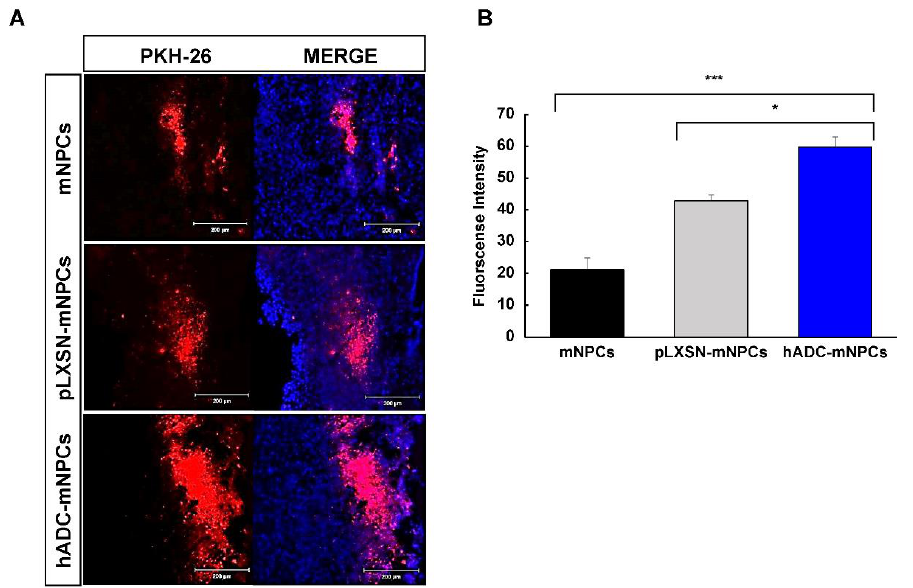
Figure 1. Migration and survival of mNPCs around the lesion site at 1 week after cell transplantation following SCI. ( A ) A higher number of PKH-26-labeled hADC-mNPCs grafted found around the lesion area (T9) than there were mNPCs and pLXSN-mNPCs at 1 week after cell transplantation. ( B ) More PKH-26-labeled hADC-mNPCs (60% fluorescence intensity) were present around the lesion area (T9) than there were mNPCs (20%) and pLXSN-mNPCs (40%). Data are presented as means ± standard error of mean (SEM). ( n = 5 per sample, * p < 0.05, *** p <